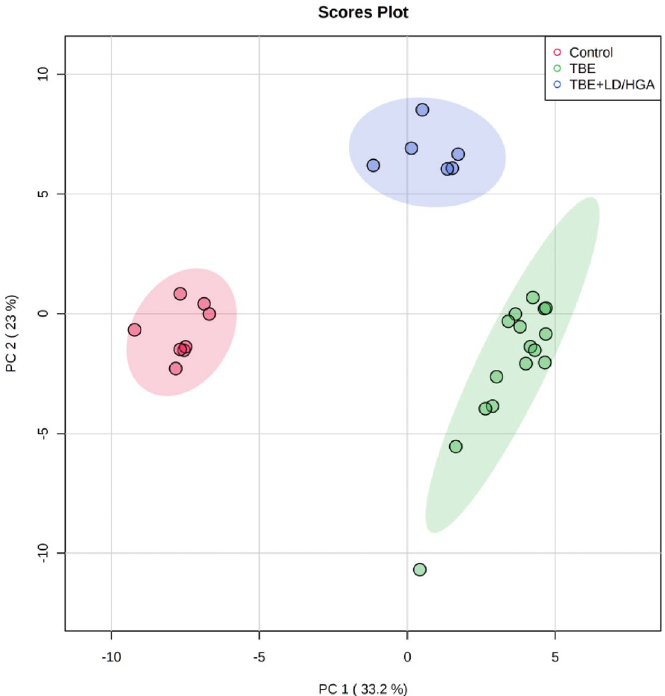
Figure 1. Two-dimensional principal component analysis (2D PCA) scores plot of the relative PL content in the plasma of healthy subjects (Control) and TBE patients (TBE) and TBE patients with co-infections (TBE + LD/ HGA).